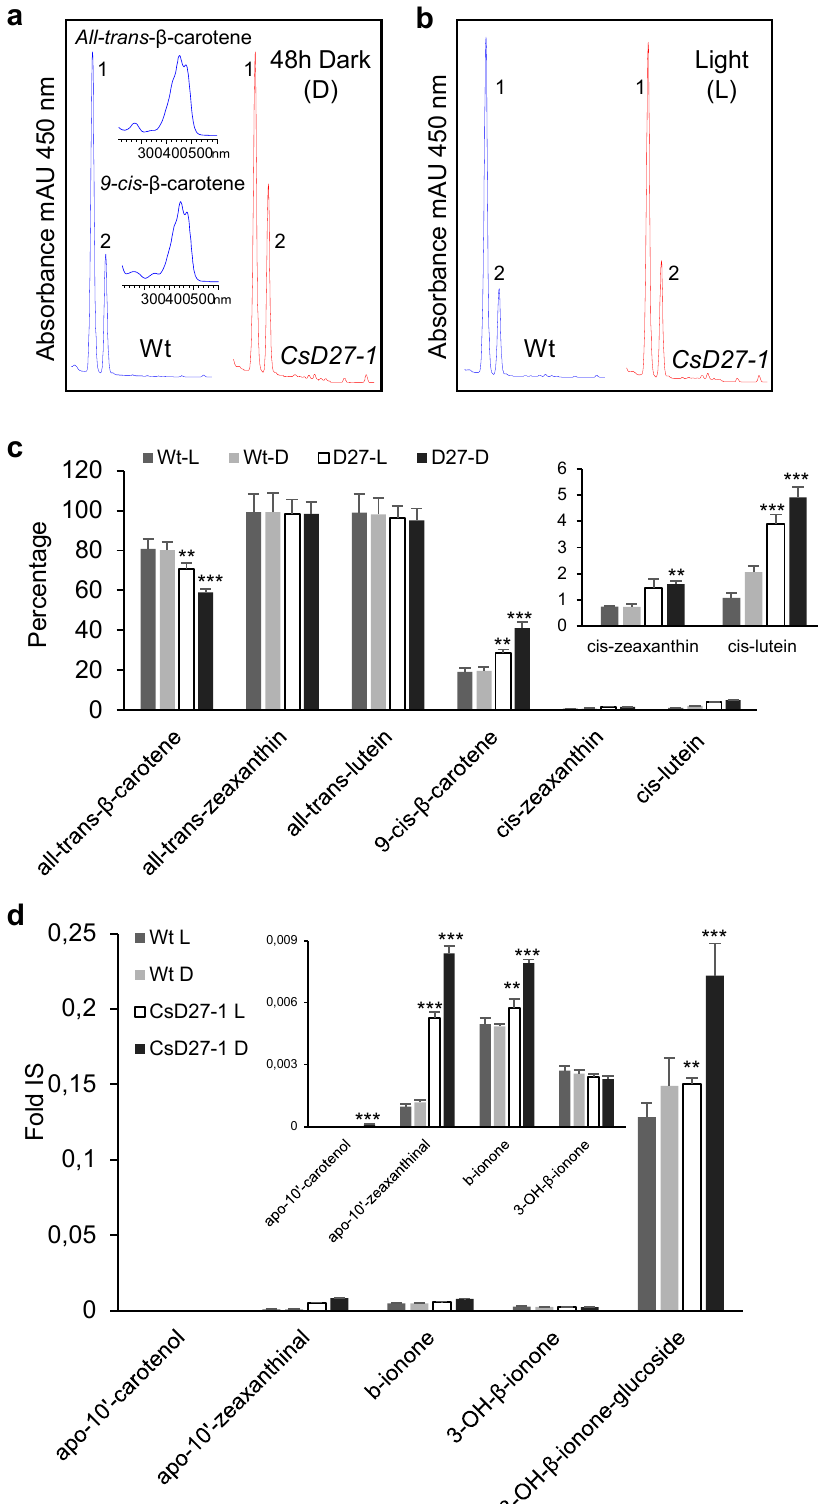
Figure 6. In planta activity of CsD27-1. ( a ) HPLC analysis of in vivo CsD27-1 activity in leaves of N. benthamiana plants grown during 48 h in dark conditions. ( b ) HPLC analysis of in vivo CsD27-1 activity in leaves of N. benthamiana plants grown under standard light conditions. ( c ) Percentage of cis-9- β -carotene isomer was significantly increased in N. benthamiana leaves agroinfiltrated with 35S::CsD27-1 in both dark and under standard light conditions. Ratio was calculated based on